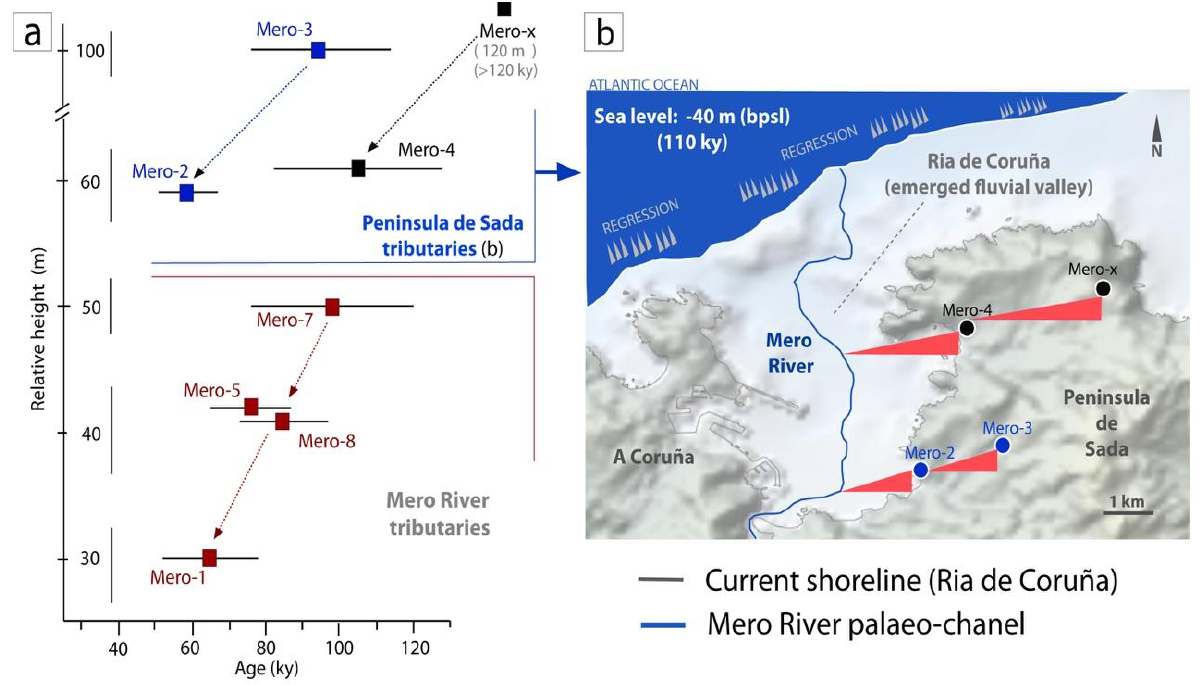
Figure 5. ( a ) Chronology of alluvial sediments from lower Mero River and relative heights from the main paleochannel. ( b ) Alluvial deposits from Peninsula de Sada tributaries (Mero4–Merox and Mero3–Mero2), with a sea level of − 40 m below present sea level (bpsl), 110 ky ago. Mero-x: undated sample (most probably older than 120 ky) at 120 m (relative height). The triangles show the slope (tangent line) between samples and the bottom of the Ria de Coruña (then emerged) and represented by the hypothetical Mero river palaeo-channel. Elevation model and bathymetry from [53].